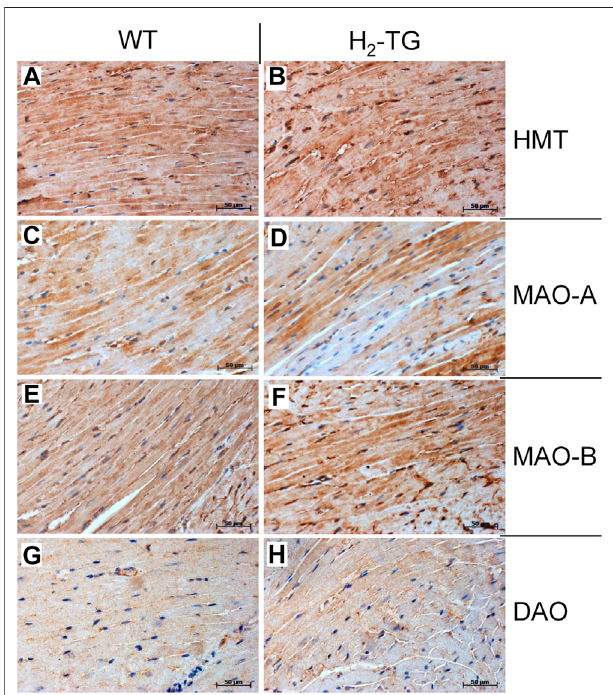
FIGURE 7 | Immunohistochemical detection of histamine-metabolizing enzymes in the mouse myocardium. The localization of histamine-N- methyltransferase (HMT, A,B ), monoamine oxidase A (MAO-A, C,D ) and B (MAO-B, E,F ) as well as diamine oxidase (DAO, G,H ) in the myocardium of H 2 -TG mice and wild-type mice (WT) is shown. Immunocomplexes were detected by DAB-HRP staining (brown staining) and nuclei were visualized by counterstaining with haematoxylin. Horizontal bars indicate 50 µm.